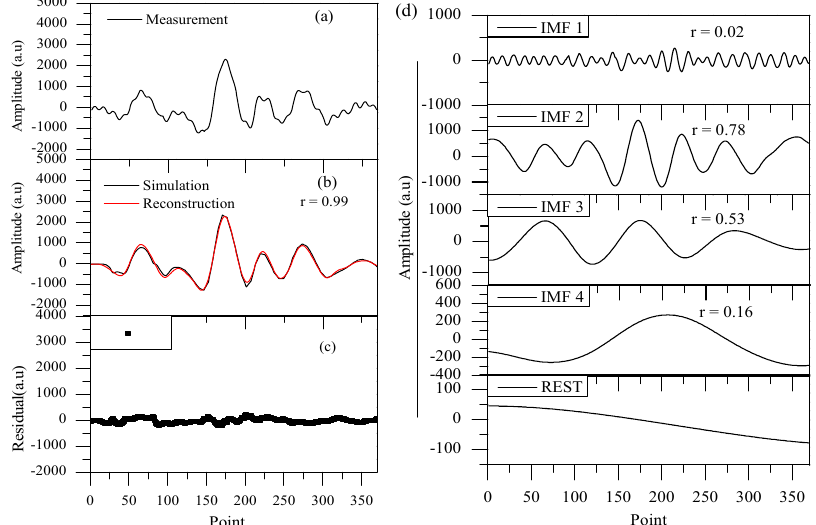
Figure 5. ( a ) The detected 2 f signals; ( b ) the reconstructed 2 f signal versus simulated 2 f signal; ( c ) the residuals between simulation and reconstruction signals; and ( d ) the collection of IMFs that EMD decomposed from the detected 2 f signal.